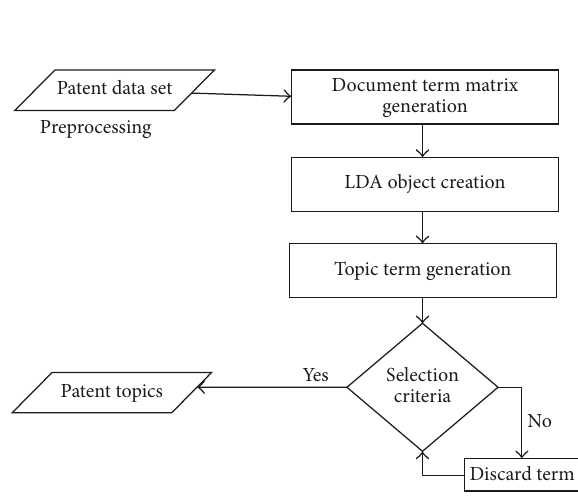
Figure 8: Flowchart for applying LDA algorithm in patent topic